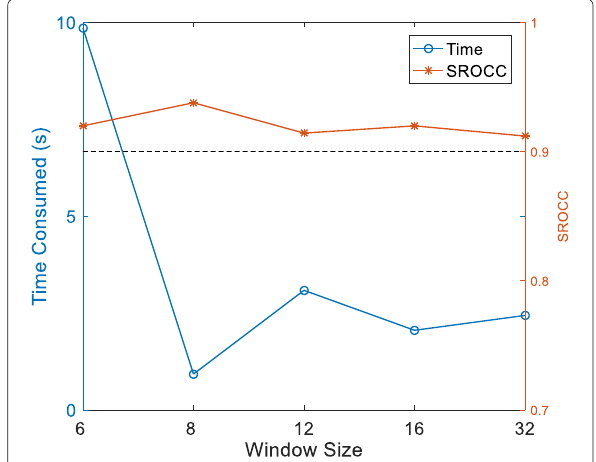
Fig. 5 Line charts between the selected window size and the overall SROCC value as well as the average time consumed on evaluating a single image according to Table 3. When the window size is set to 8 × 8, the method achieves best SROCC